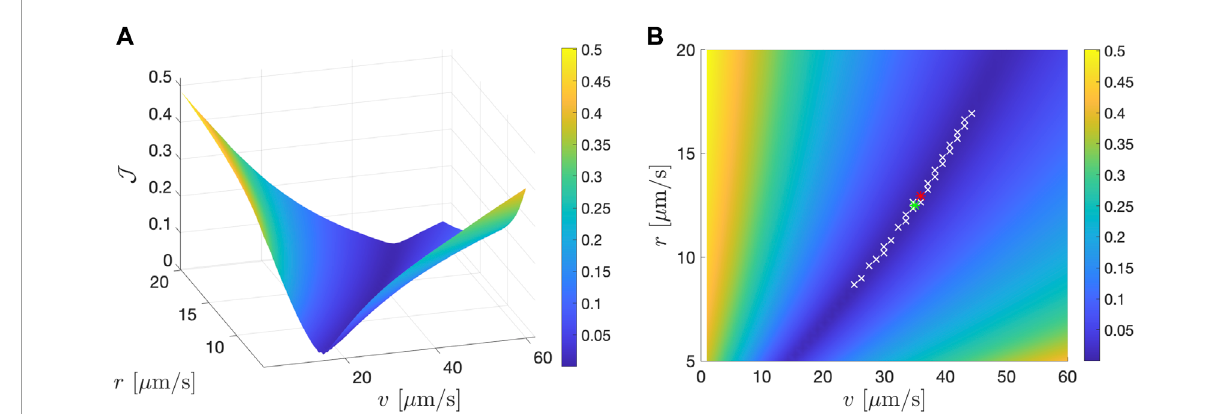
FIGURE 2 (A) Discrepancy functional J ( υ , r ) evaluated on a 50 × 50 grid on the parametric space I υ × I r . (B) White crosses indicate the points for which J ( υ , r )/ max ( J ) < 10 − 2 . The obtained minimum (in red) is not he best possible approximation for ( υ , r ) = ( 35 , 12 . 5 ) (in green).